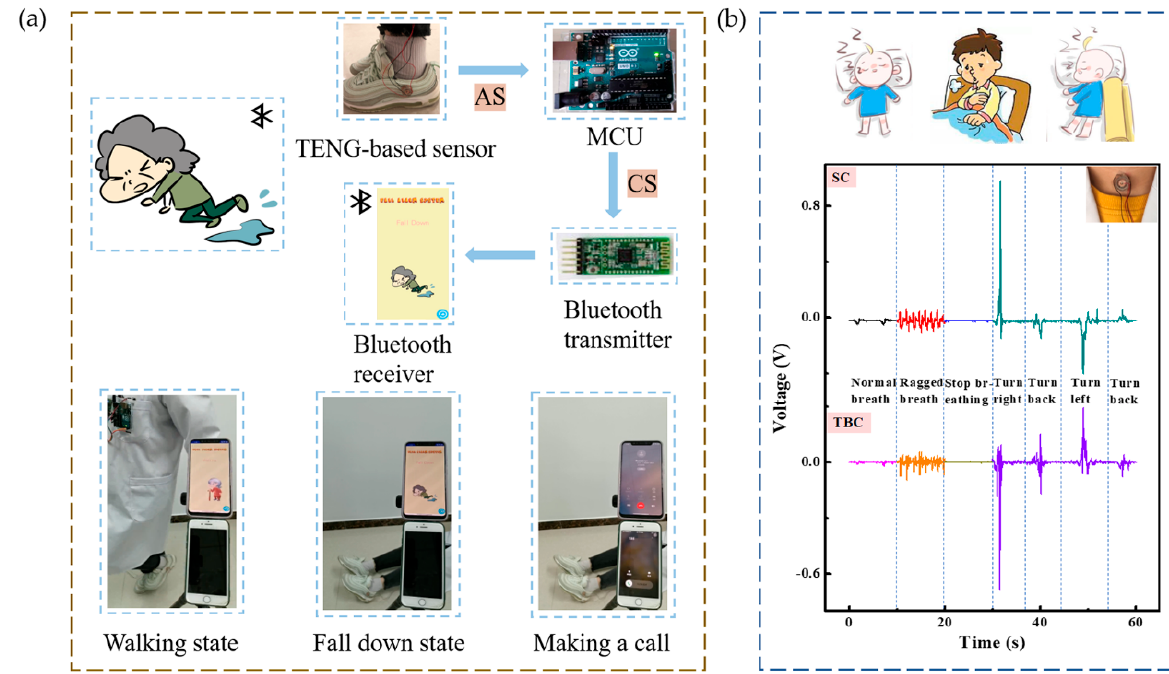
Figure 4. Demonstrations of the SWS for ( a ) motion state monitoring and fall-down alarm system and ( b ) sleep state monitoring.